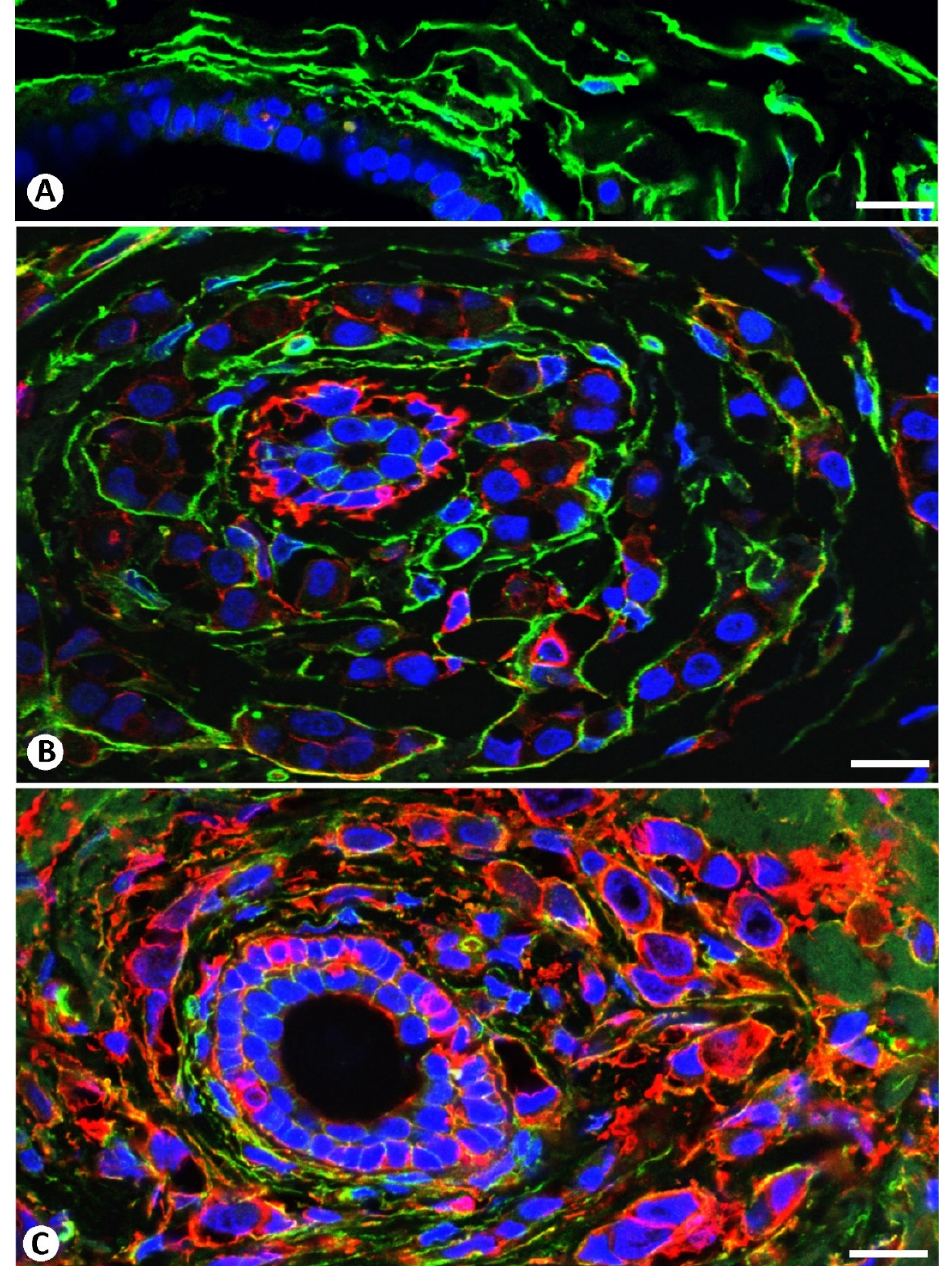
Figure 5. Double immunofluorescence labelling for CD34 (green) and α SMA (red) with DAPI (blue) counterstain. ( A ): CD34+SCs/TCs (green) around a duct. ( B , C ): Rings of CD34+ (green) and α SMA+ (red) stromal cells surrounding neoplastic cells (blue stained nuclei) around ducts. Note the predominance of CD34+ stromal cells in ( B ) and of α SMA+ stromal cells in ( C ). Some stromal cells coexpress both markers. Bar: ( A ): 40 µm; ( B , C ): 30 µm. CD34+SC/TC distribution in the intralobular interstitium (Figure 6A) also corre- sponded to that of stromal cells around infiltrative neoplastic cells in invasive lobular car- cinoma (Figure 6B).